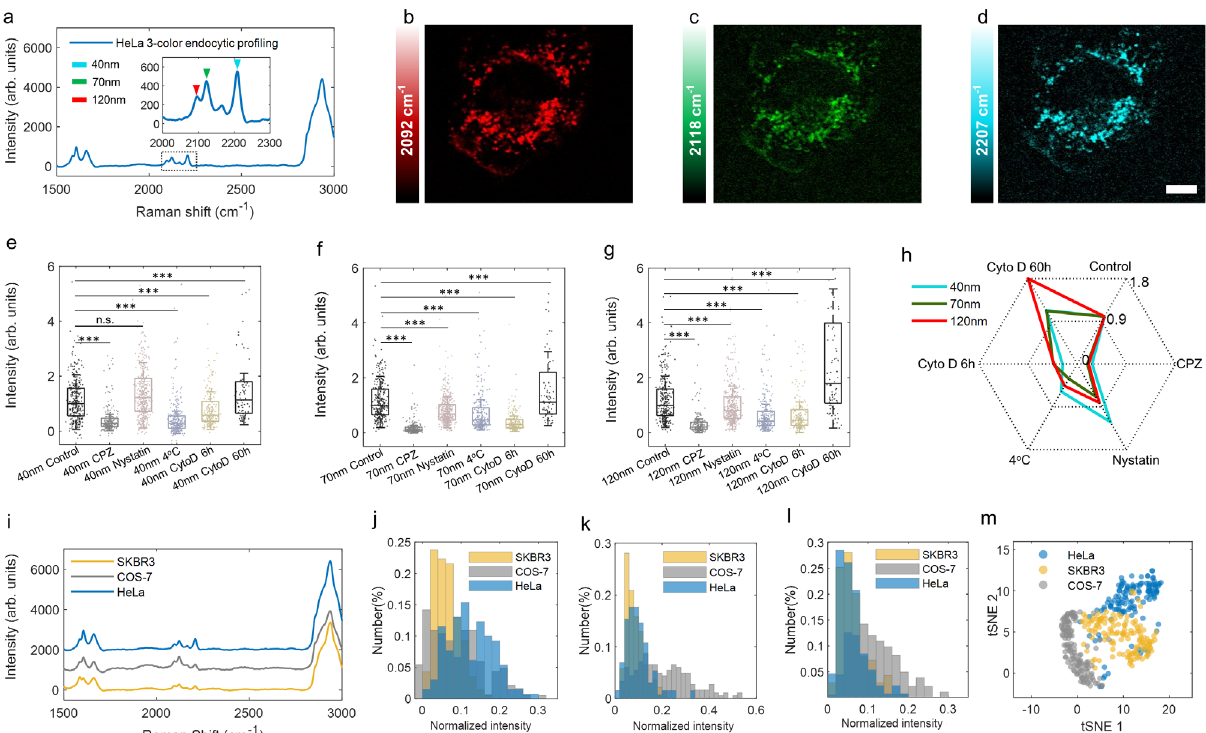
Fig. 4 Endocytic pro fi ling assay by multi-color Rdots. a Spontaneous Raman spectra of HeLa cells acquired after incubated with Rdot2207 (40 nm), Rdot2118 (70 nm), and Rdot2092 (120 nm) for 6 h, averaged over 128 individual cells. The peak position of each Rdots was indicated by the arrow. b – d SRS images of cellular distribution for three endocytic Rdots, b 40 nm, c 70 nm, d 120 nm, scale bar: 10 µ m. The color scales display relative SRS signal levels. Image results were representative of four biological replicates. e – g Box plot illustrating the normalized Raman intensity distribution of three endocytic Rdots under the stress of clathrin inhibitor CPZ and caveolae inhibitor nystatin, low temperature and actin inhibitor Cyto D (incubated for 6 h and 60 h), e 40 nm, f 70 nm, g 120 nm. Box edges indicate the interquartile range (IQR); center line, median; whiskers, lowest and highest data within 0.5IQR from the fi rst and third quartiles, respectively. N = 309; N = 209; N = 387; N = 255; N = 198; N = 87. *** denotes a signi fi cant control CPZ nystatin 4°C Cyto D 6h Cyto D 60h difference between the two groups ( P < 0.001, two-tailed). n.s. denotes not signi fi cant ( P > 0.05, two-tailed). The exact P values were provided in the source data. h Properties of inhibition displaying on Radar diagrams and each inhibition action is provided with an axis. i Averaged spontaneous Raman spectra of HeLa, SKBR3, and COS-7 cells acquired after incubated with three endocytic Rdots for 6 h, N HeLa = 128; N SKBR3 = 134; N COS-7 = 130. j – l Histogram showing the Raman intensity distribution of three endocytic Rdots uptake by HeLa, SKBR3, and COS-7 cells, j 40 nm, k 70 nm, l 120 nm. m Three-color endocytic pro fi ling of HeLa and SKBR3 and COS-7 cells projected on t-SNE plot, colored by cell